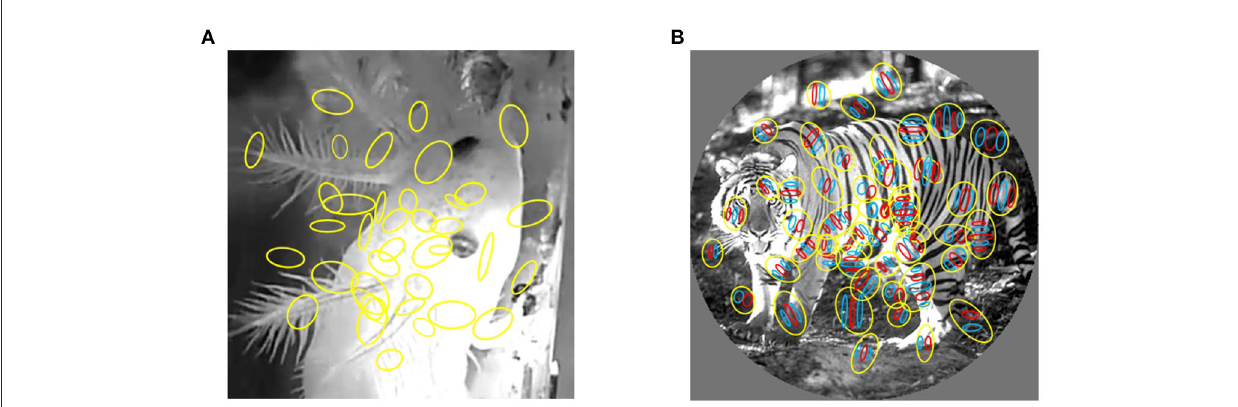
FIGURE1 Mapping of receptive fields to video frames. (A) Receptive fields of salamander RGCs. (B) The receptive fields of macaque primary visual cortex neurons. Each yellow colored circle is an outline of receptive field. The red and blue region represent excitatory and inhibitory subregions, respectively.